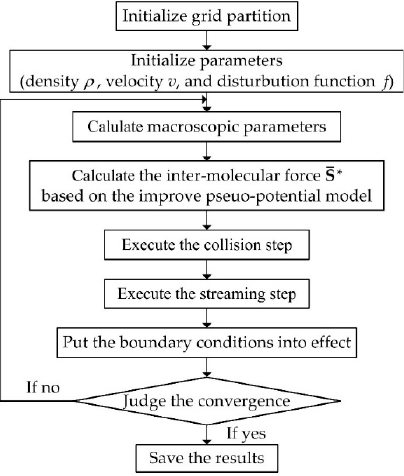
Figure 3. The flowchart of the improved pseudo-potential MRT-LBM.